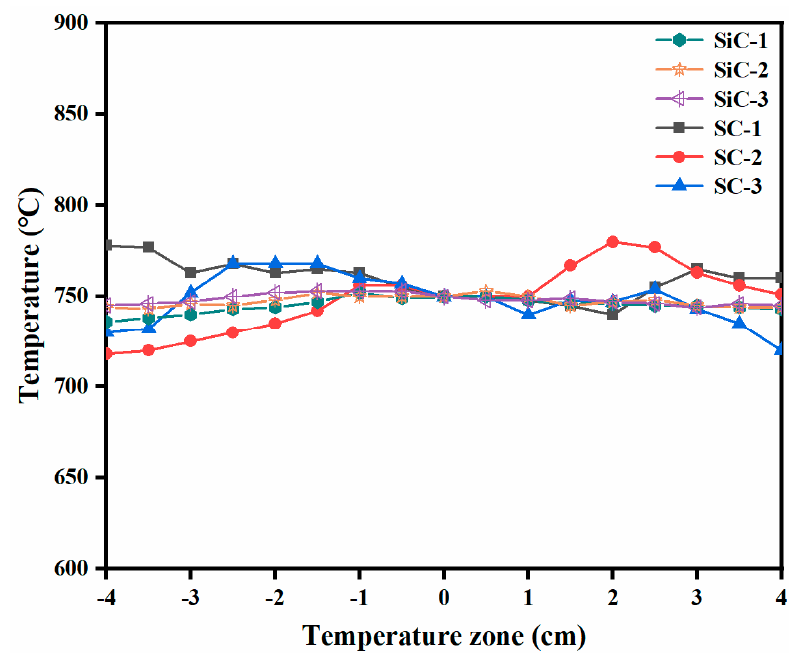
Figure 1. Temperature correction diagram of silicon carbide (SiC) and semi-coke (SC).